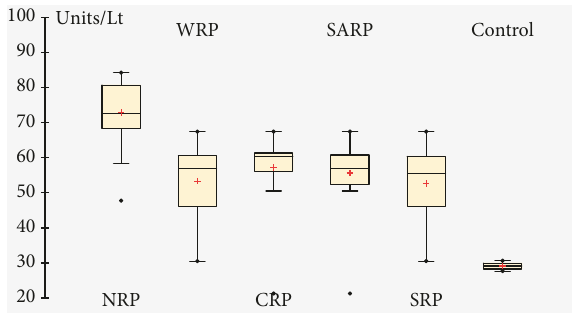
Figure 8: Serum glutamate-pyruvatetransaminase (SGPT) activity.